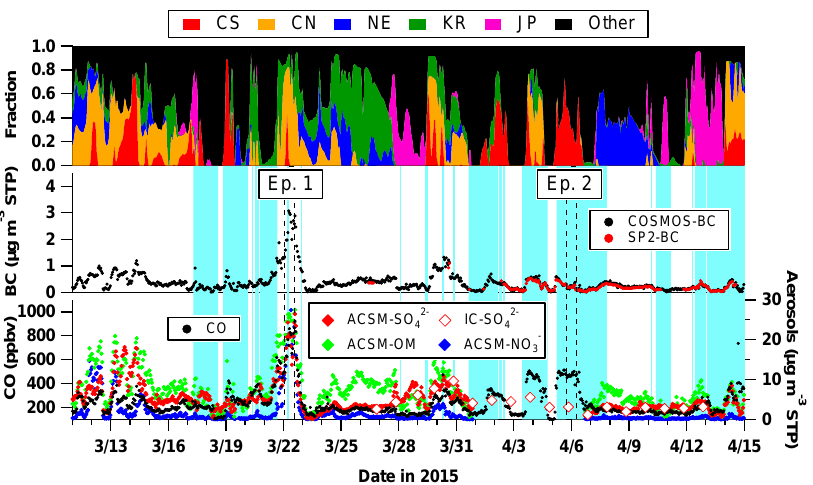
Figure 5. Temporal variations in air mass origin and concentration of trace species. Top panel: fractional residence time of air masses passing over selected area (red – Central South China; orange – Central North China; blue – Northeast China; green – Korea; pink – Japan; black – other regions such as the ocean). Middle panel: mass concentrations of BC measured using COSMOS (black markers) and SP2 (red markers). Bottom panel: concentrations of CO (black markers), SO 2 − (red closed and open markers for ACSM and IC, respectively), ACSM-NO − 4 3 (blue markers), and ACSM-OM (light green markers). The periods with an APT>3mm are highlighted in light blue in the middle and bottom panels. The periods denoted as Eps. 1 and 2 (see the text for details) are enclosed by dashed